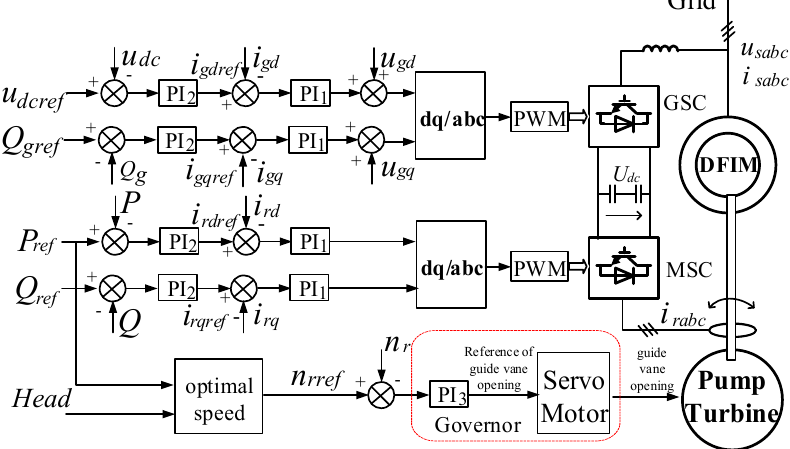
Figure 10. Overall control diagram of power priority control strategy.